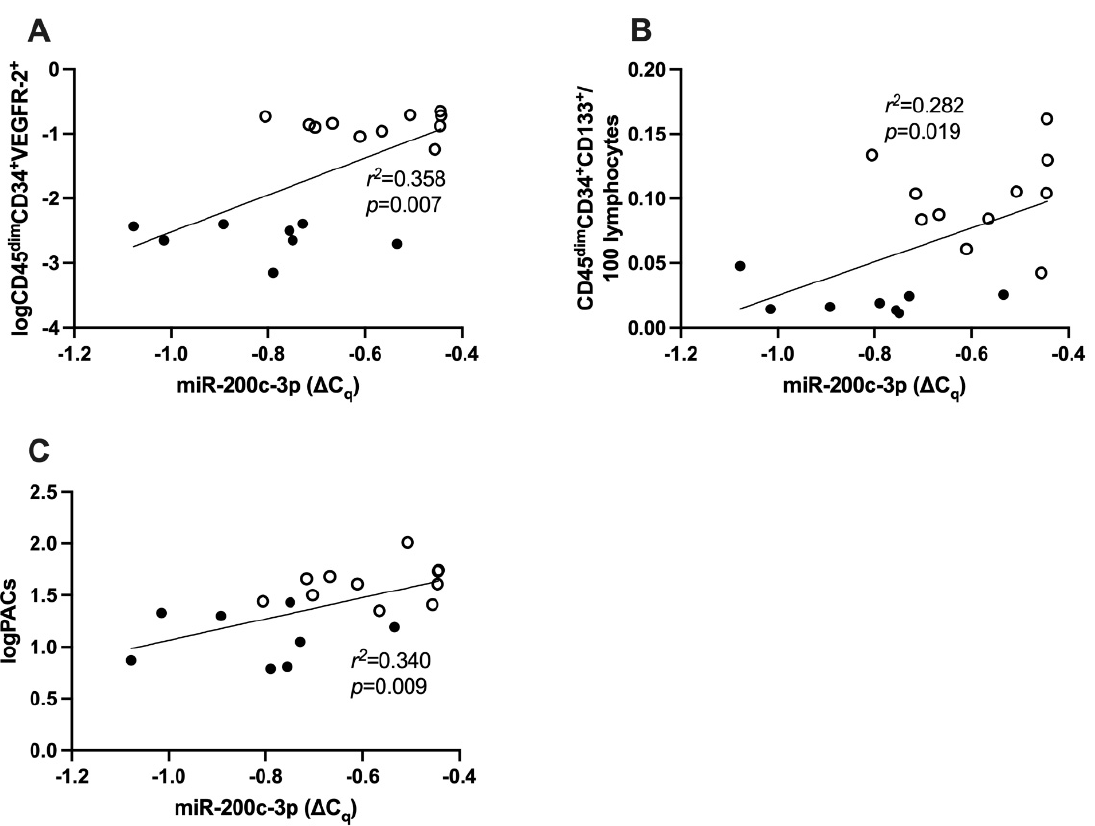
Figure 3. Correlation between miR-200c-3p expression in PBMCs and vascular health in type 1 diabetes and healthy controls combined. ( A ) miR-200c-3p and CD45 dim CD34 + VEGFR-2 + ( B ) miR-200c-3p and CD45 dim CD34 + CD133 + ; ( C ) miR-200c-3p and logPACs. Statistical analysis was carried out using linear regression analysis. CD: cluster of differentiation; PAC: proangiogenic cells. 2.8. Receiver Operating Characteristic Curve Analysis of miR-200c-3p and T1DM Receiver operating characteristic curve (ROC) analyses showed that miR-200c-3p was able to distinguish between T1DM and HC (AUC = 0.886, p = 0.005) with a sensitivity of 87.5% and 90.91% specificity (Figure 4A). In addition, significant downregulation of